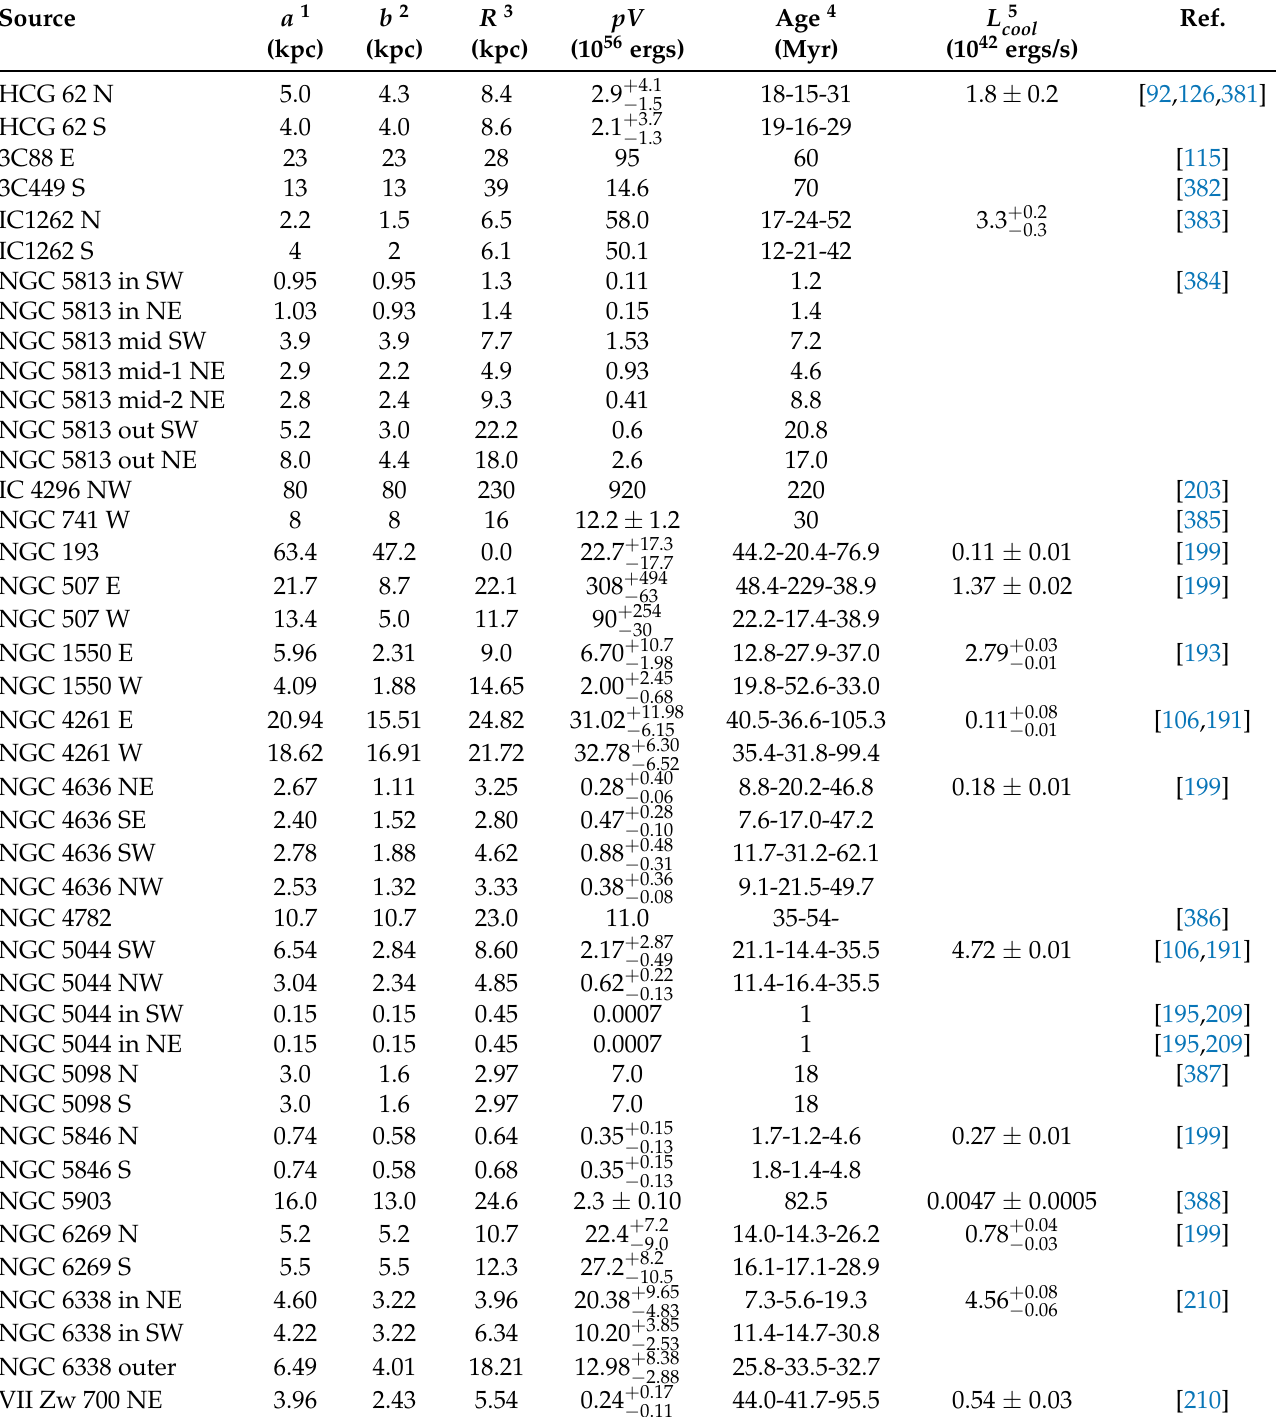
Table A1. Properties of the cavities detected in groups. Only quantities available from the literature are included, thus for some systems the listing will be incomplete. 1 Projected semi-major axis of the cavity. 2 Projected semi-minor axis of the cavity. 3 Projected distance from the cavity center to the core. 4 Ages are reported as t s - t buoy - t refill . Where only a single value is reported, this is t s . 5 Bolometric luminosity between 0.001 and 100 keV inside r cool , where the cooling time is less than 7.7 Gyr. (cid:63) Additional data provided by Nulsen, P., priv.